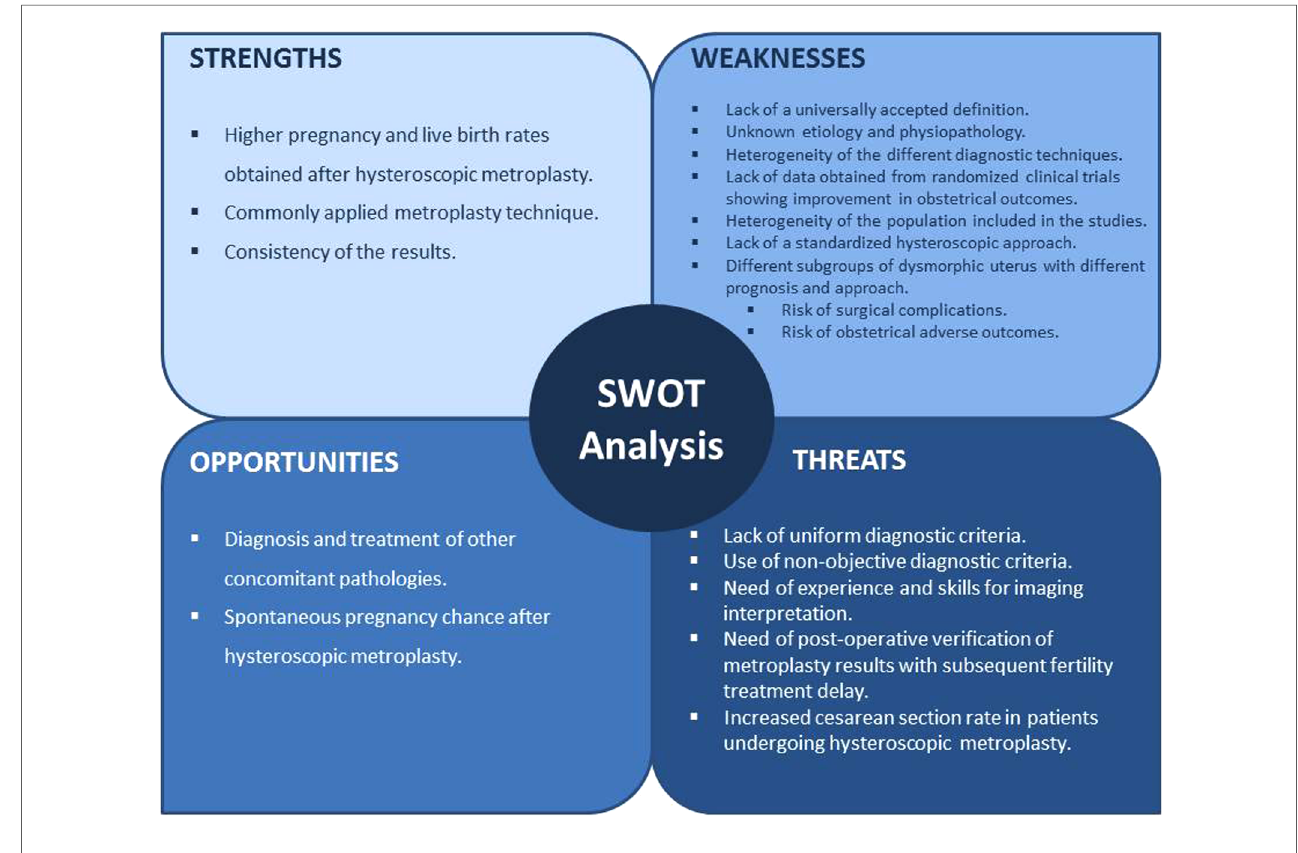
FIGURE 1 SWOT analysis of hysteroscopic metroplasty for the treatment of the dysmorphic